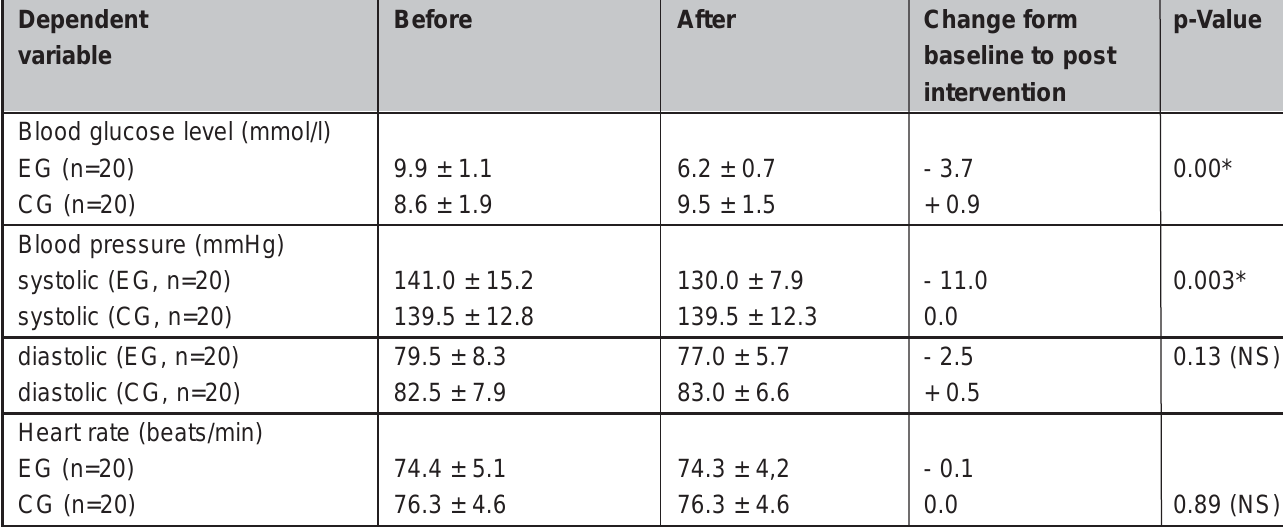
Table 3: Blood glucose level, blood pressure and heart rate data pre and post